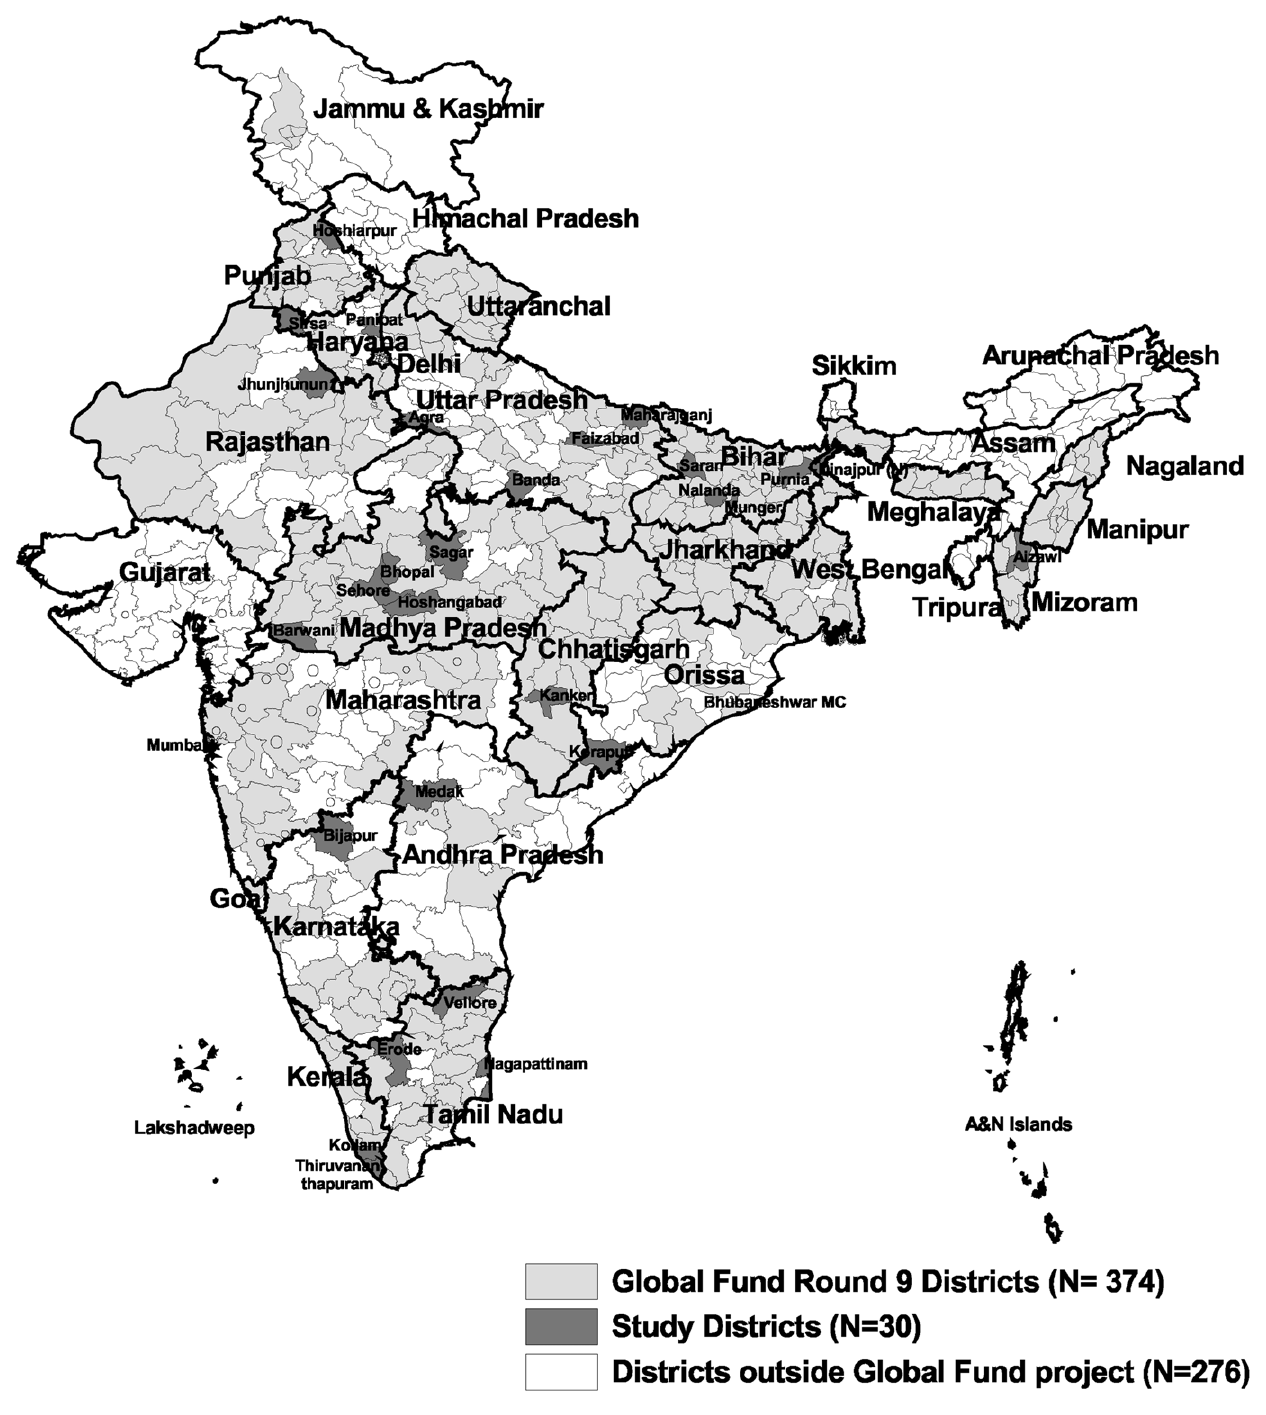
Figure 1. State and district map of India showing the Global Fund Round 9 India TB project districts, and the 30 districts that were selected for the survey.